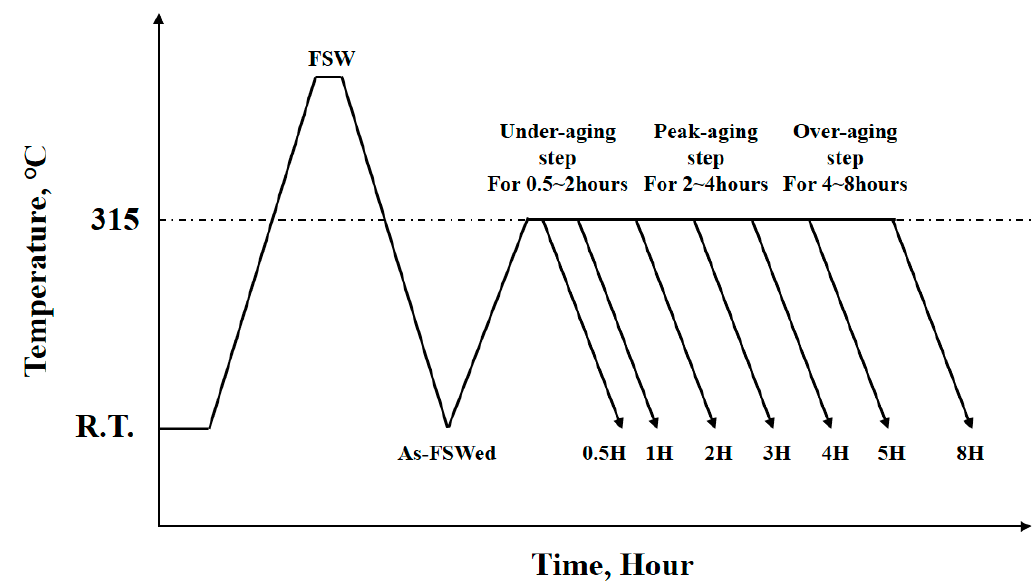
Figure 4. Process flow chart including the friction stir welding (FSW) and post-weld heat treatment